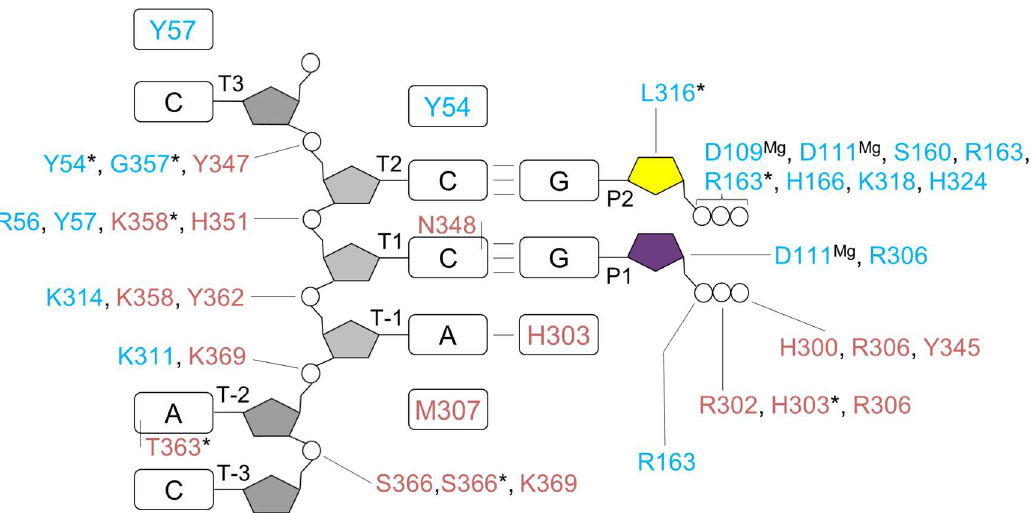
Figure 5. Interaction of human primase with a DNA template and rNTPs during RNA synthesis initiation. The color scheme is the same as in Figure 4. The residues of p49 interacting with the DNA template and the initiating GTP are identified from the model of the initiation complex. The asterisk indicates that a main-chain atom of the amino acid forms a hydrogen bond with a nucleotide. Amino acids participating in stacking interactions with nucleotides are shown in rectangular boxes.